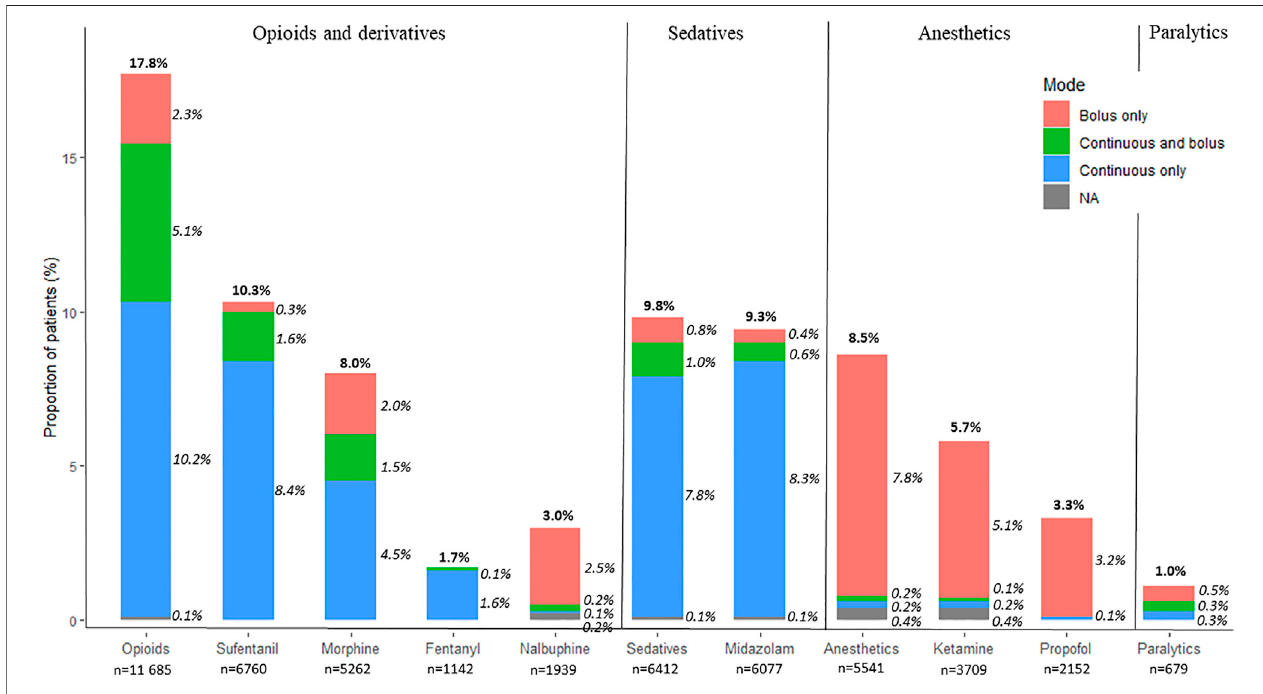
FIGURE 2 | Proportion of neonates with a prescription for commonly used opioids, sedatives, anesthetics, and paralytics, and the methods of their administration (bolus only, continuous and bolus, or continuous only). NA corresponds to patients for whom the method of administration was not available. Percentages were calculated with the total number of patients with a prescription as the denominator ( n = 65,555). Percentages may not sum up to 100% due to rounding.